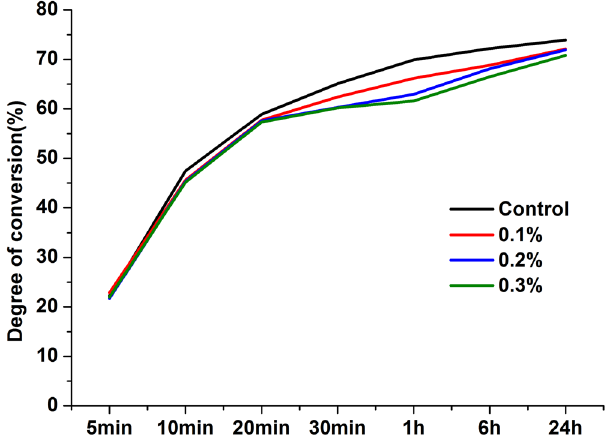
Figure 9. Degree of conversion of PMMA resin. The results are presented as the mean ± SD (n = 9). During the first 10 min curing period, DC increased dramatically, and after curing for 20 min, DC increased more slowly. At 24 h, the DC values of each group were all more than 70.0%, with no significant differences (P > 0.05) among the groups.